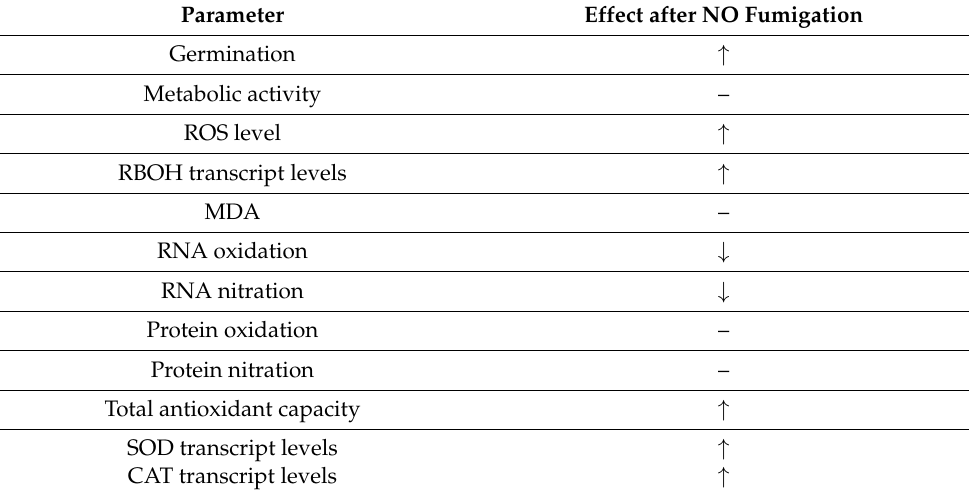
Table 2. Post-ageing NO action in the apple embryos. The changes of the rate of the parameters analyzed in the experiment in which embryos isolated from seeds subjected to 21 days of accelerated ageing were fumigated with NO. Parameter Effect after NO Fumigation